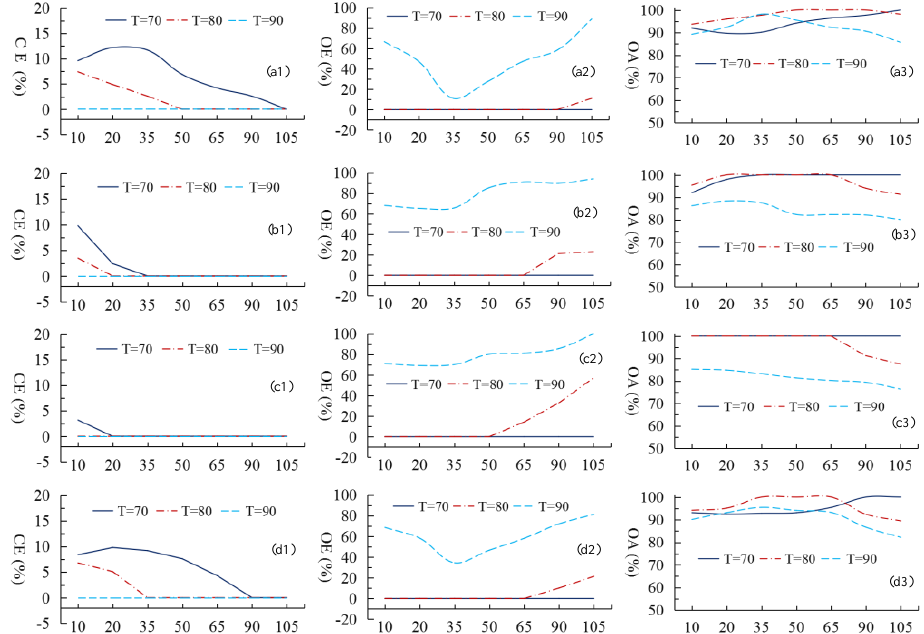
Figure 14. Accuracy analysis of outlier detection by using different k values and FSOI threshold: ( a1 – a3 ) are commission errors, omission errors, and overall accuracy of cultivated land, respectively; ( b1 – b3 ) are commission errors, omission errors, and overall accuracy of forest, respectively; ( c1 – c3 ) are commission errors, omission errors, and overall accuracy of buildings, respectively; ( d1 – d3 ) are commission errors, omission errors, and overall accuracy of water bodies, respectively. Note: Transverse axis denotes k values, and T denotes FSOI threshold. CE: commission errors, OE: omission errors, and OA: overall accuracy.